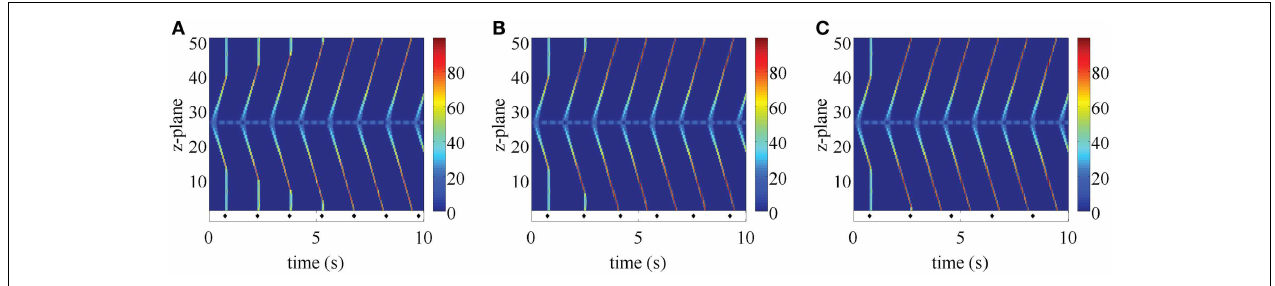
FIGURE 6 | Paced ping wave initiated as in Figure 4 for a pacing period of t p = 1.5s (A), 1.7s (B), and 1.9s (C). Each stimulation is indicated by a diamond symbol.The first pacing pulse is delivered at 0.75s.The refractory period in the central z-plane is 0.34s, while